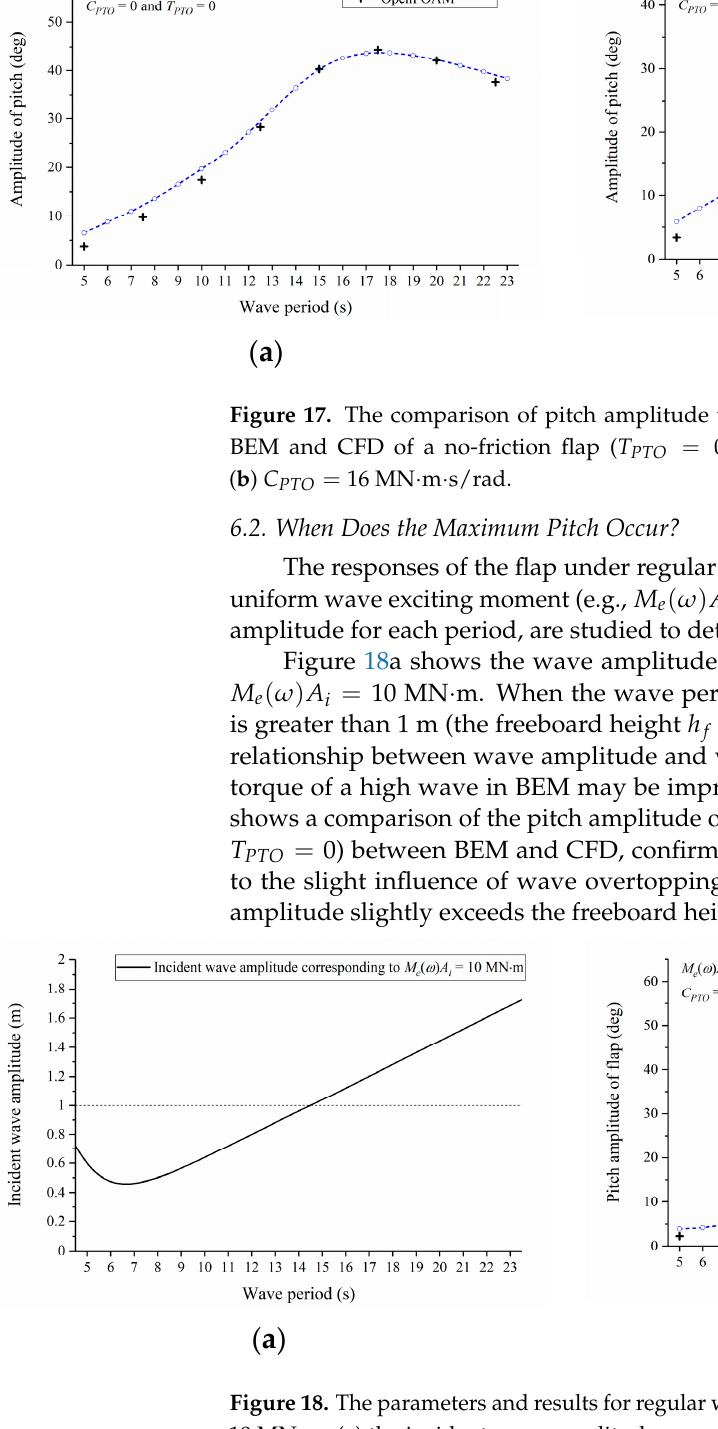
Figure 18. The parameters and results for regular waves of uniform wave exciting moment ampli- tude 10 MN ∙ m : ( a ) the incident wave amplitude vs. period; ( b ) comparison between BEM and CFD of a flap without a PTO system ( 𝐶 (cid:3017)(cid:3021)(cid:3016) = 0 and 𝑇 (cid:3017)(cid:3021)(cid:3016) = 0 ).